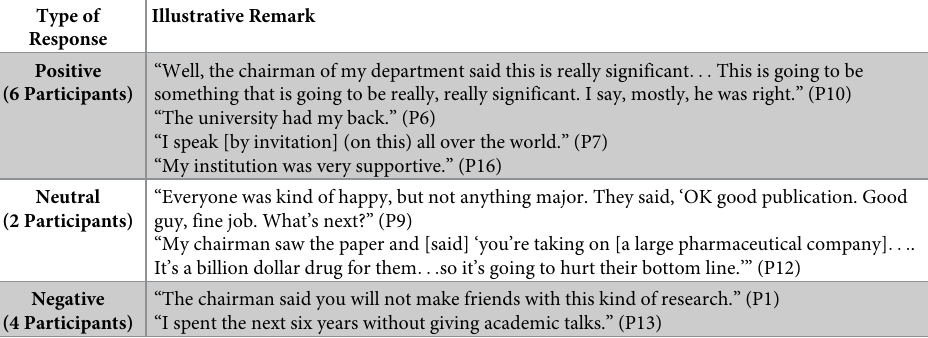
Table 3. Interviewee report of academic community